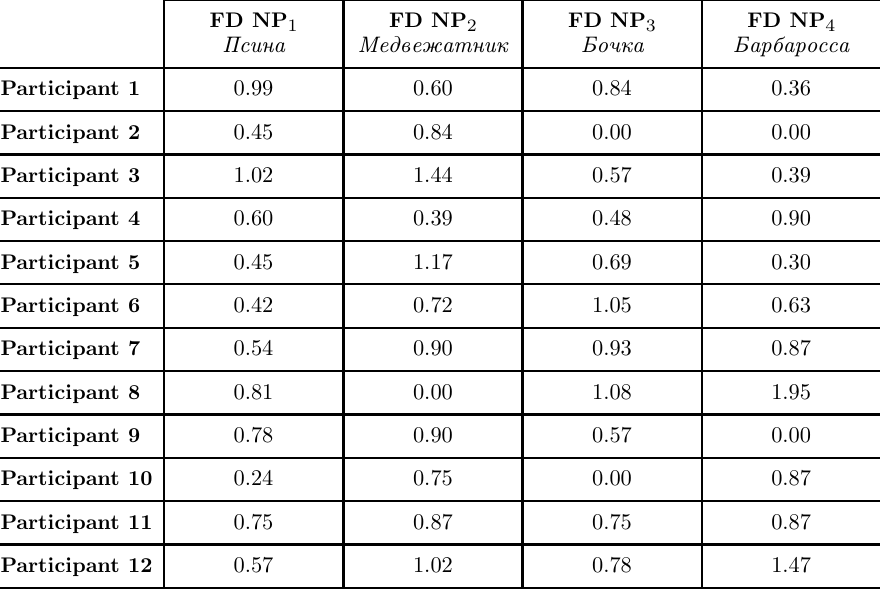
Noun phrases reading times (Fixations Duration)